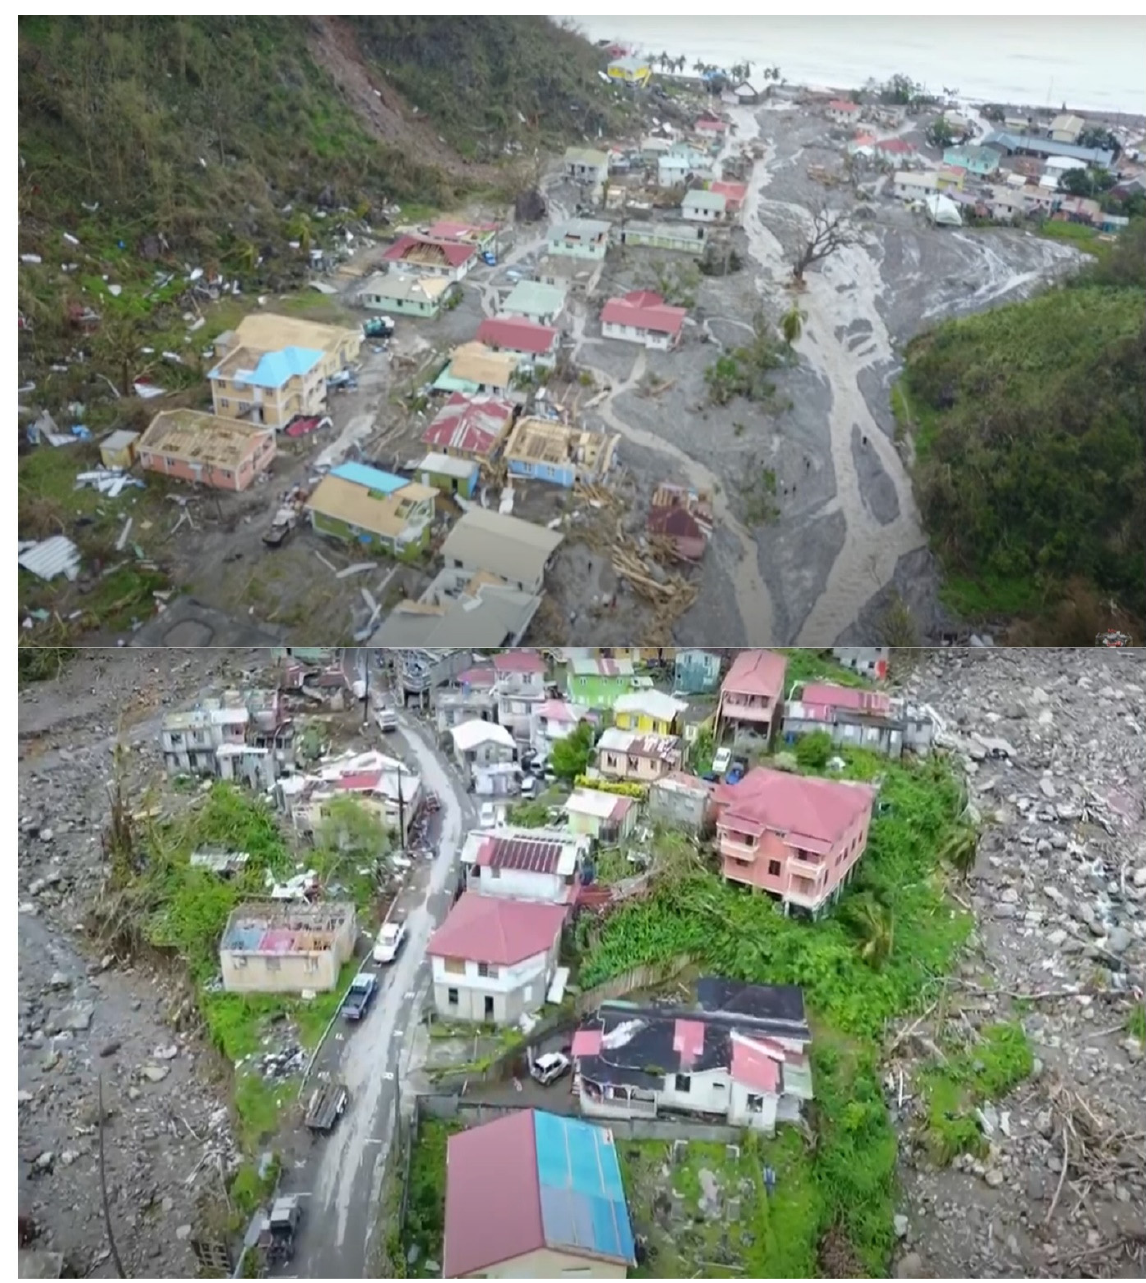
Figure 2. Above: oblique view of Coulibistrie village immediately after Hurricane Maria: sediment deposition has a high spatial variability and it is a mixture of sediments, rocks and boulders, and tree debris (UAV video available at https://www.youtube.com/watch?v=QTuymqtkfig&t=62 (accessed on 5 May 2021)). Below: oblique view of Pichelin village, taken shortly after the event. The village is located between two valleys that were filled with debris (UAV video available at https://www.youtube.com/watch?v=1aaPY-309Ko (accessed on 5 May 2021)).